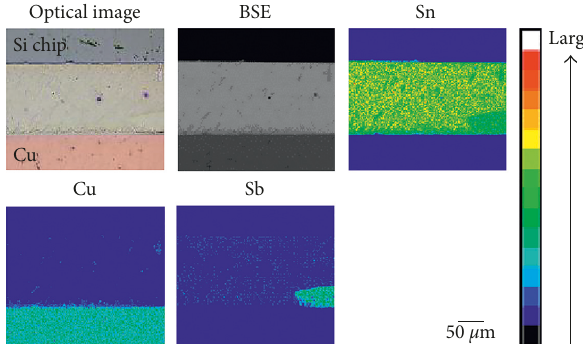
Figure 4: Optical image and back-scattered electron image of cross section of the solder joint with Sn-10Sb and its EPMA mapping analysis result.